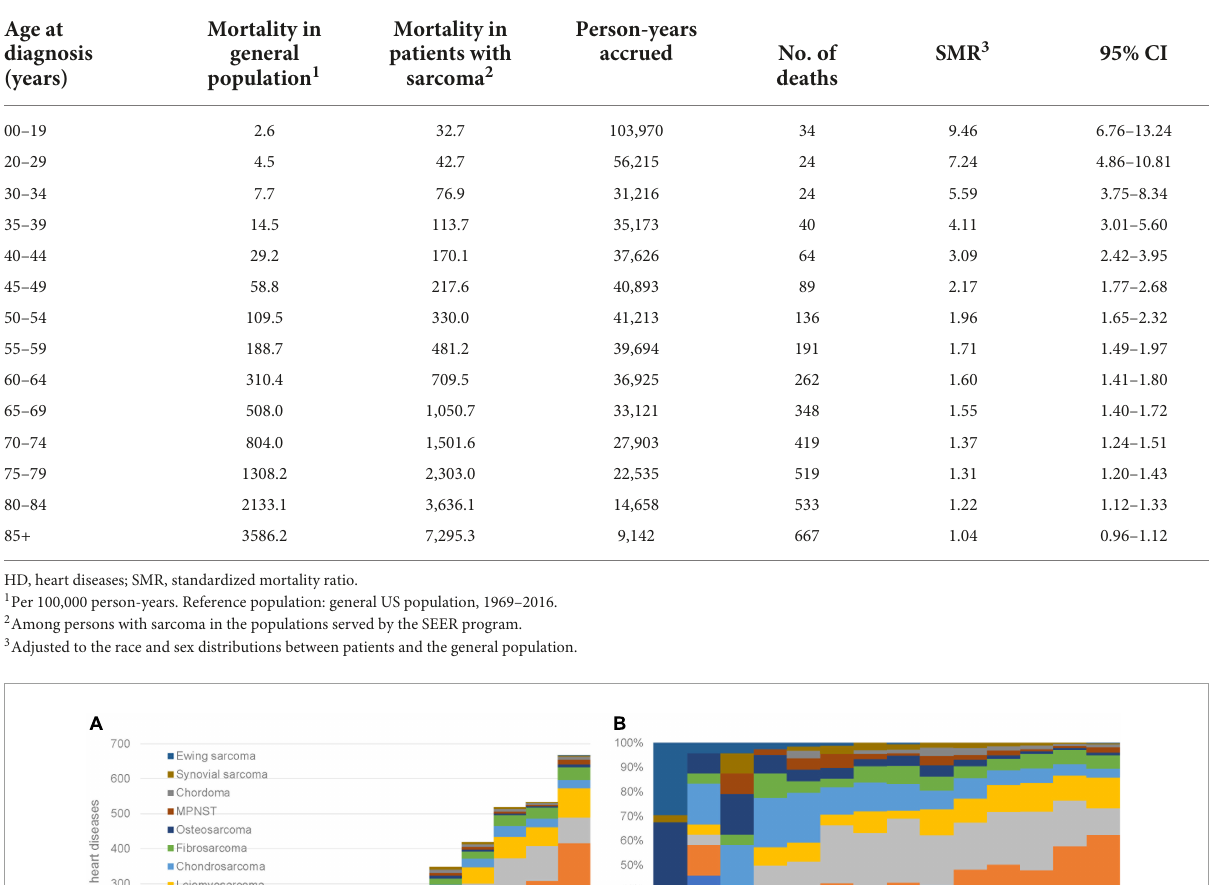
TABLE 2 Risk of fatal HD among patients with sarcoma by age at diagnosis.